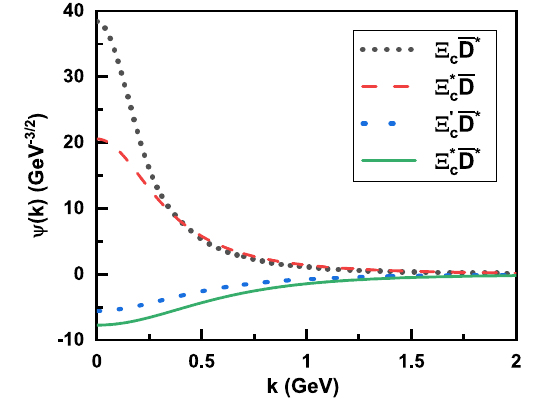
Fig. 2 The radial wave functions for the P cs ( 4459 ) as a coupled ¯ D ∗ /(cid:2) ∗ ¯ D /(cid:2) (cid:3) ¯ D ∗ /(cid:2) ∗ ¯ D ∗ molecule with I ( J P ) = 0 ( 3 / 2 − ) in the (cid:2) c c c c momentum space. It is obtained by performing the Fourier transfor- (cid:24) d 3 r e i k · r ψ( r ) . Here, its binding energy is mation, i.e., ψ( k ) = E = − 19 . 28 MeV